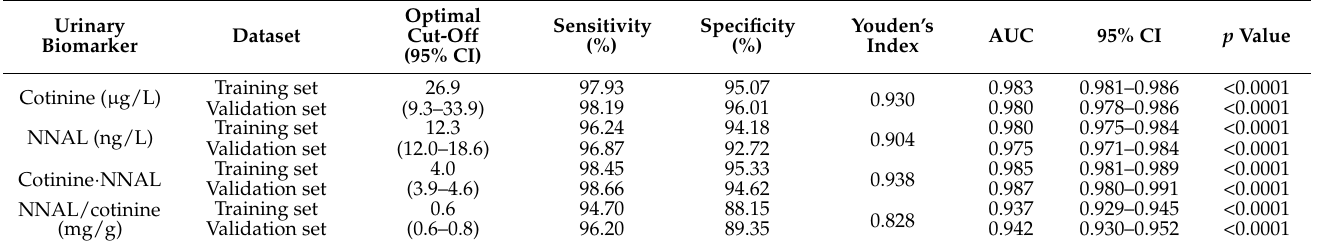
Table 2. The established optimal cut-off values of four urinary biomarkers using the training set and their diagnostic performance for smoking status